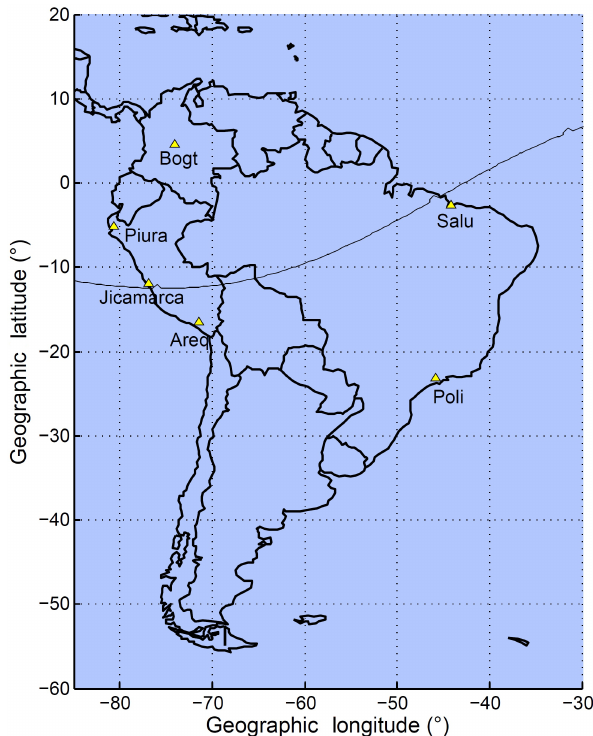
Figure 1. Locations of four GPS stations (Bogt, Areq, Poli, Salu) and two magnetometers (Jicamarca and Piura) used in this